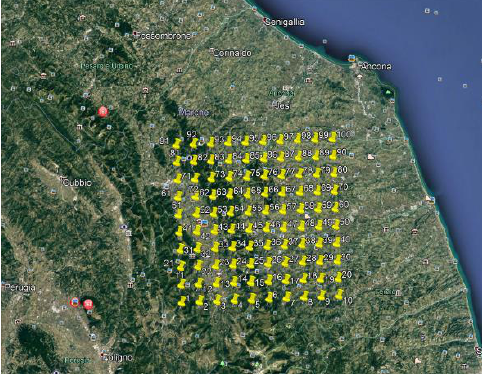
Figure 3. Grid points for the weather forecast.